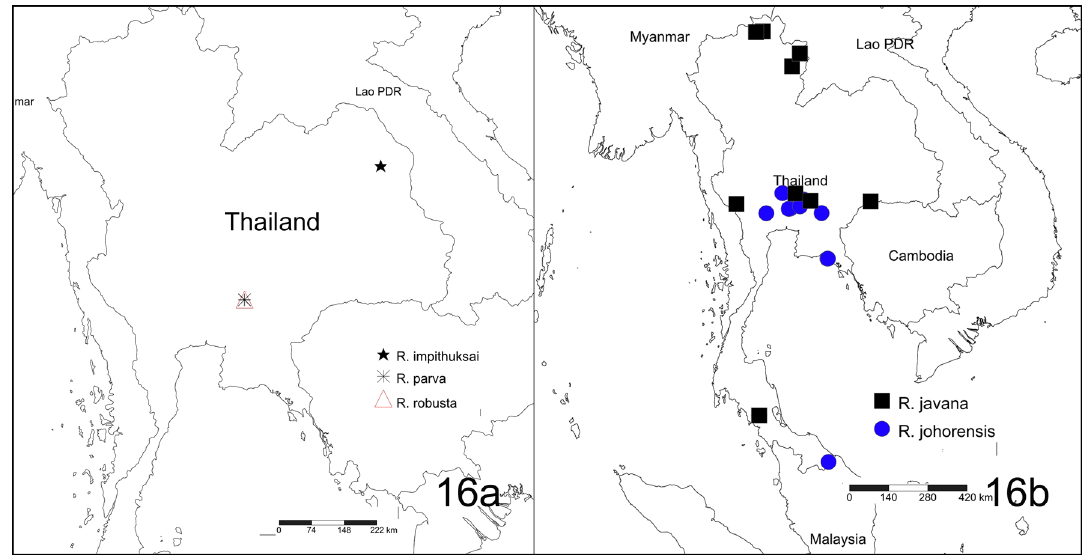
Fig. 16. Distribution maps of species of Rhopalomastix Forel, 1900 in Thailand. a . New